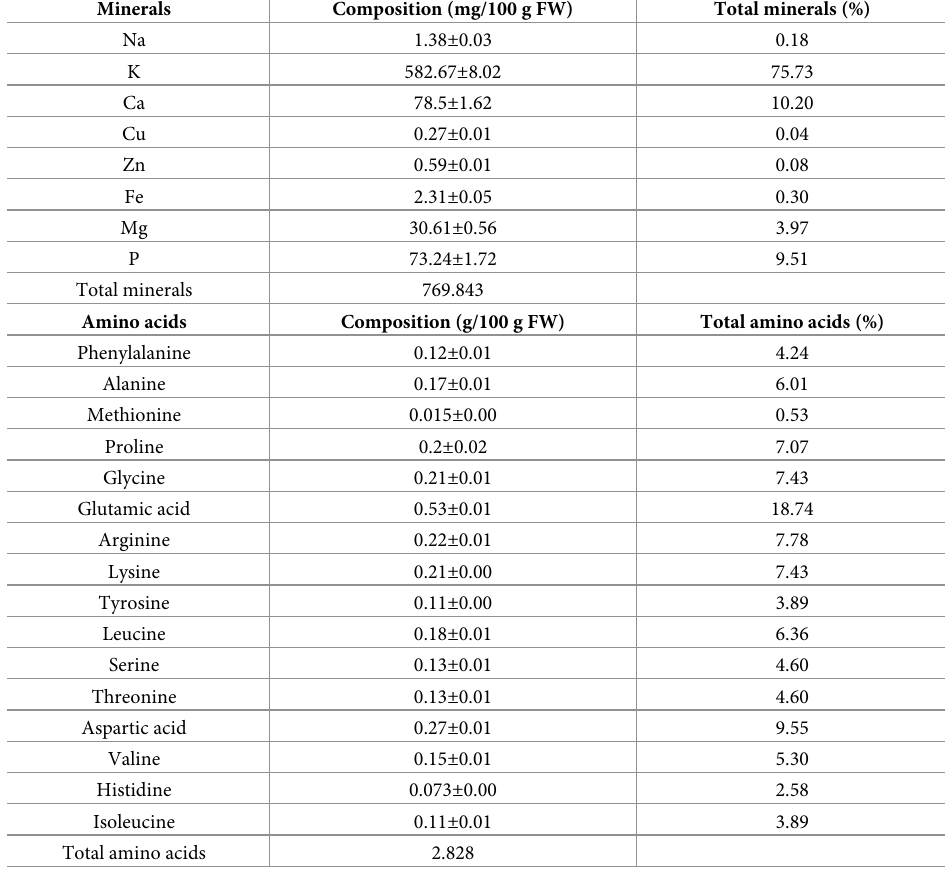
Table 2. Nutritional composition (minerals and amino acids) of Berberis heteropoda fruit.